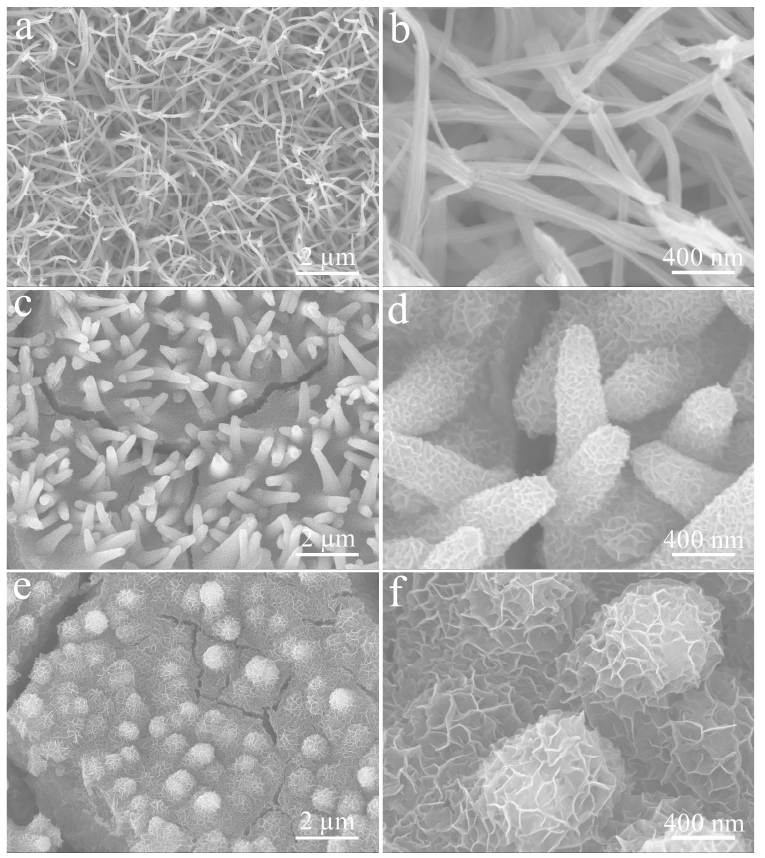
Figure 7. SEM images of CuO/NCS composites with di ff erent NCS deposition time: ( a , b ) 30 s; ( c , d ) 150 s; ( e , f ) 450 s.